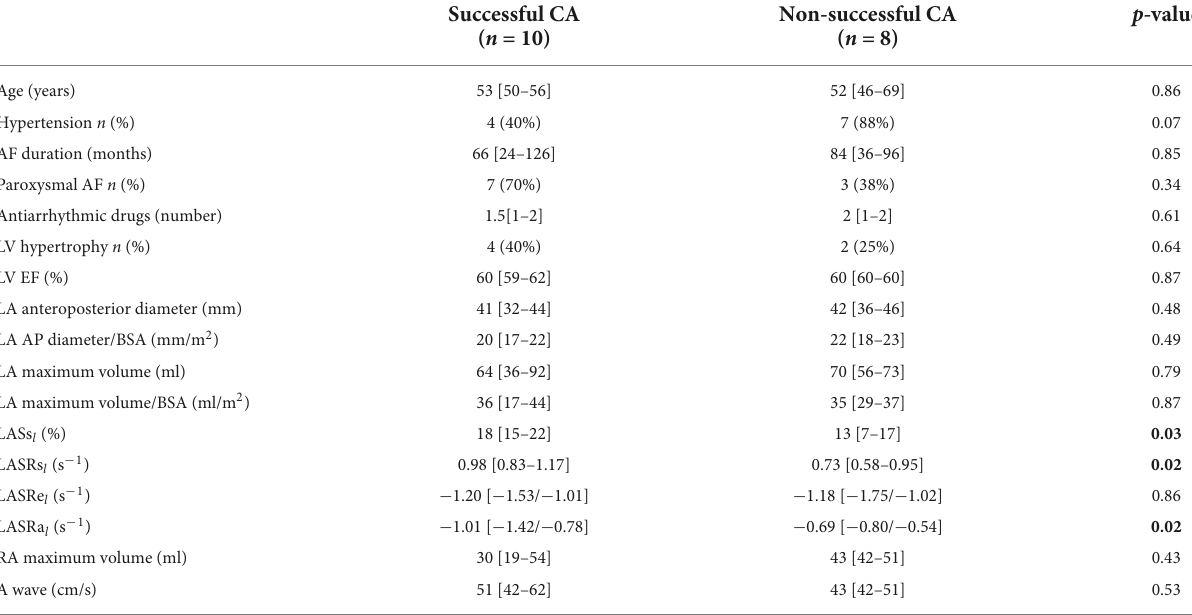
TABLE 2 Baseline characteristics of patients undergoing CA according to the success of the procedure.